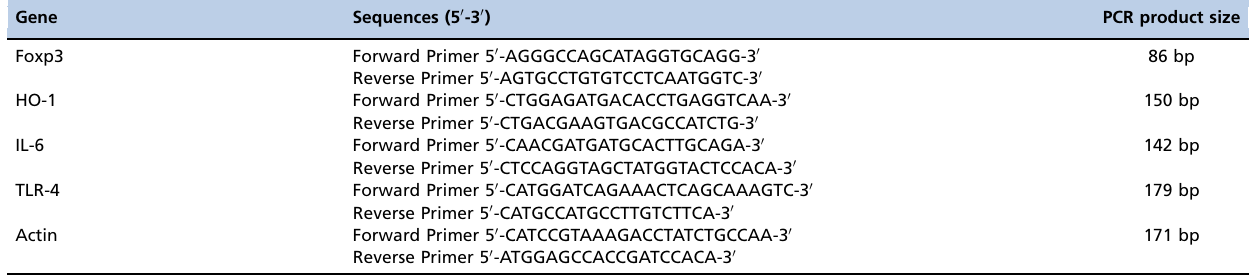
Table 1 - For qRT-PCR, the following primers were used.